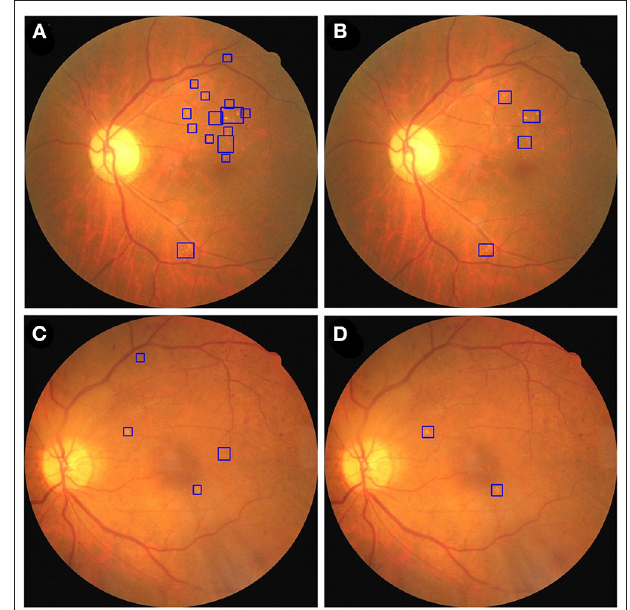
FIGURE 7 | The fusion and dual model annotate HE lesions of two fundus images from the private testing dataset. A fundus image was annotated by fusion model (A) and dual model (B) . A second fundus image was annotated by fusion model (C) and dual model (D) . HE lesions are identified using blue bounding boxes.